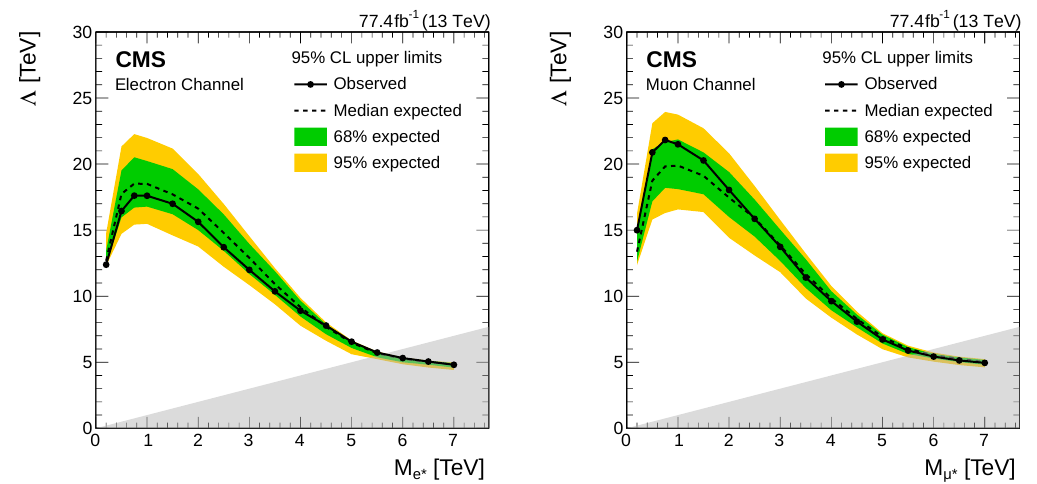
Figure 11 . Limits on the compositeness scale (cid:3) for the electron (left) and muon (right) channels, as a function of the mass of the excited lepton, for the benchmark case where the GI couplings f and f 0 vanish. The model is not valid in the hatched